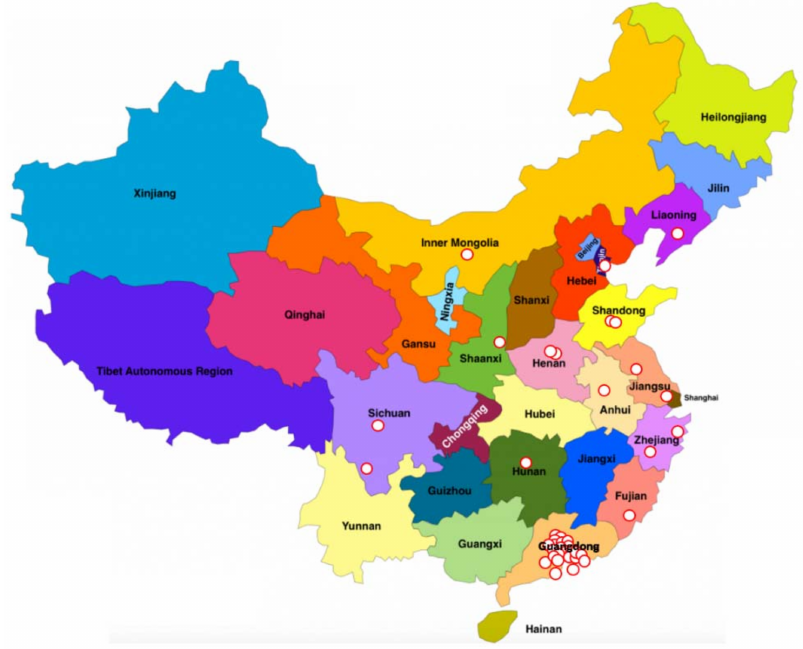
Figure 3. Locations of domestic Chinese Ni/MH battery manufacturers.